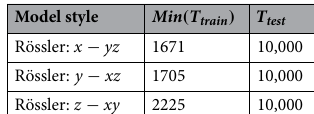
Table 3. Shortest training length of the Rössler system in the case 1 ( T test = 10 4 , RMSE < 0.1